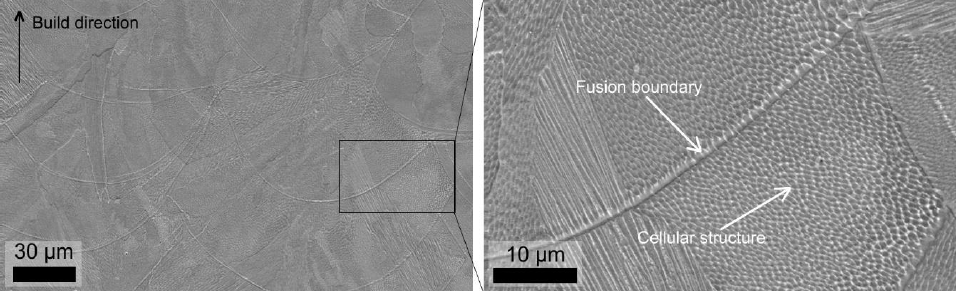
Figure 4. Scanning electron microscopy images of AsB AM 316L sample.